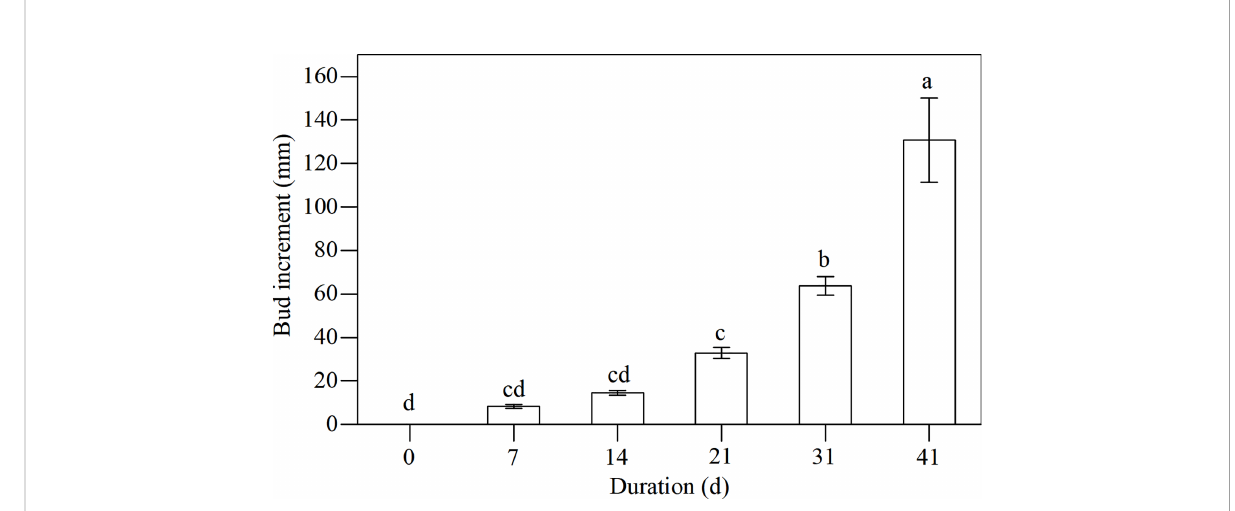
FIGURE 8 Dynamics of bud increments of L. japonica during the recovery stage. Data are presented as mean ± SE. Each batch consisted of fi ve replicates. Different letters a-d indicate signi fi cant differences (p < 0.05) in bud increment of L.